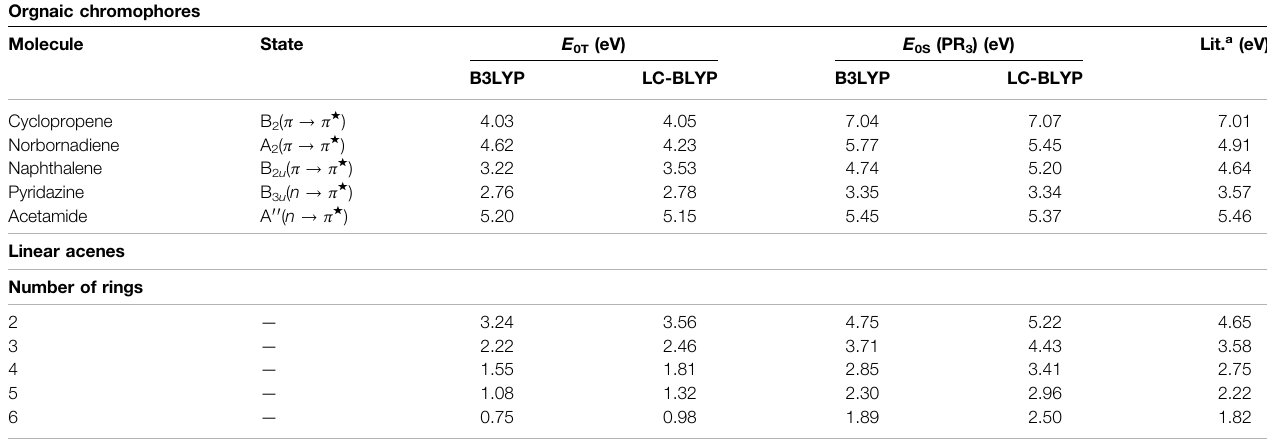
a This corresponds to E 0S from Becke (2018a).